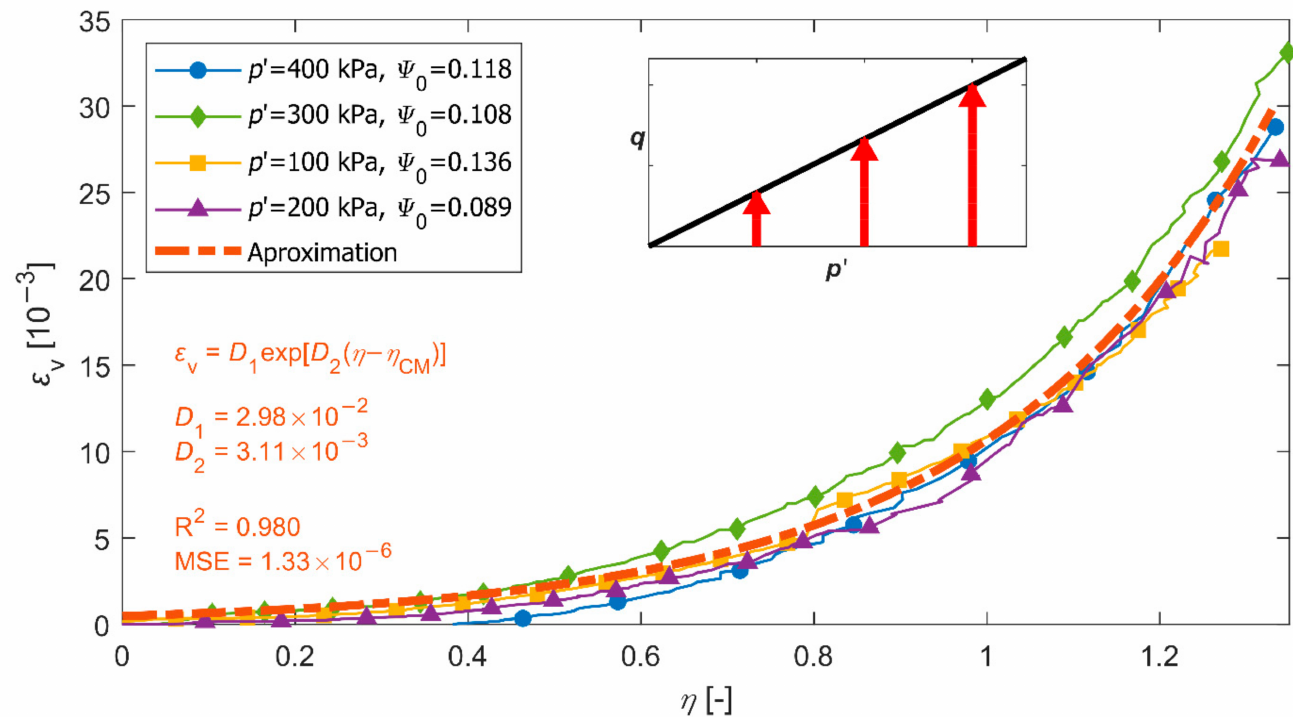
Figure 15. Volumetric strains versus stress ratio during pure shearing under triaxial conditions for contractive OZM50